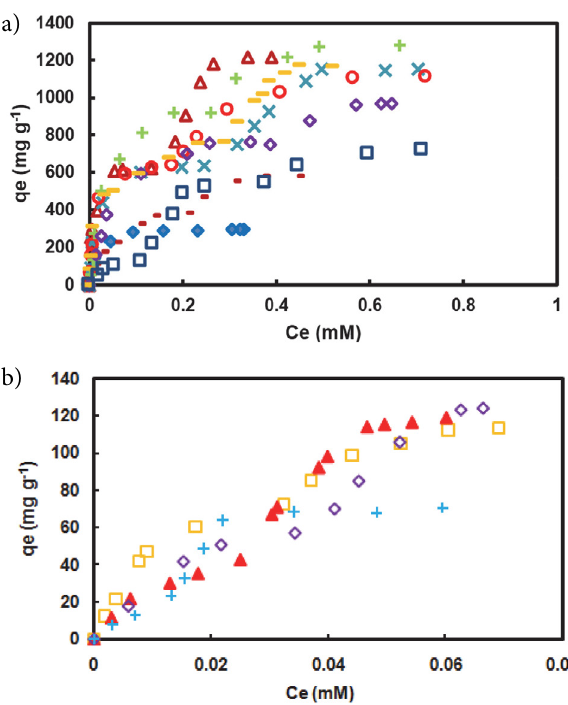
Figure 7. Adsorption isotherms of ARS on GO/PAMAM at 100 rpm and (a) at ♦ pH = 0, – pH = 0.3, ∆ pH = 1, – pH = 3 and  pH = 5 at 318 K and pH = 2 at × 308,  318 and + 328 K and (b) at  pH = 10,  pH = 13 and + pH = 14 at 318